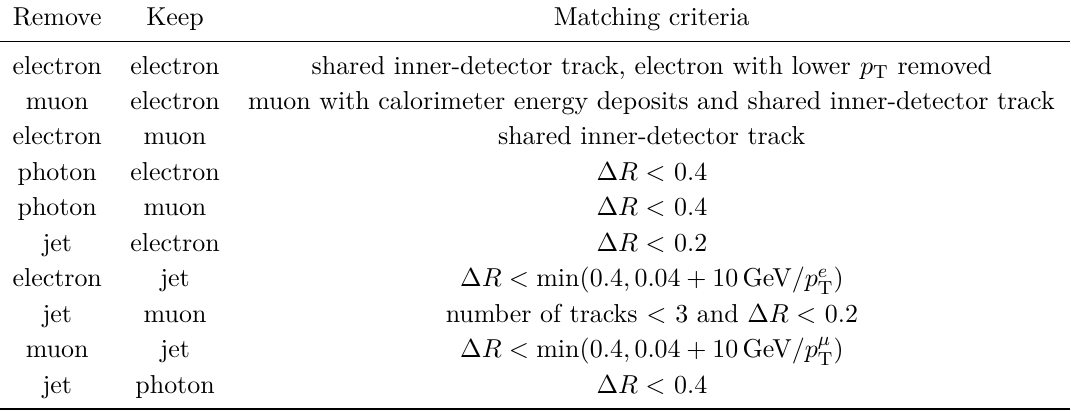
Table 2. Overview of the overlap removal procedure applied to pairs of objects and the corresponding matching criteria, listed according to